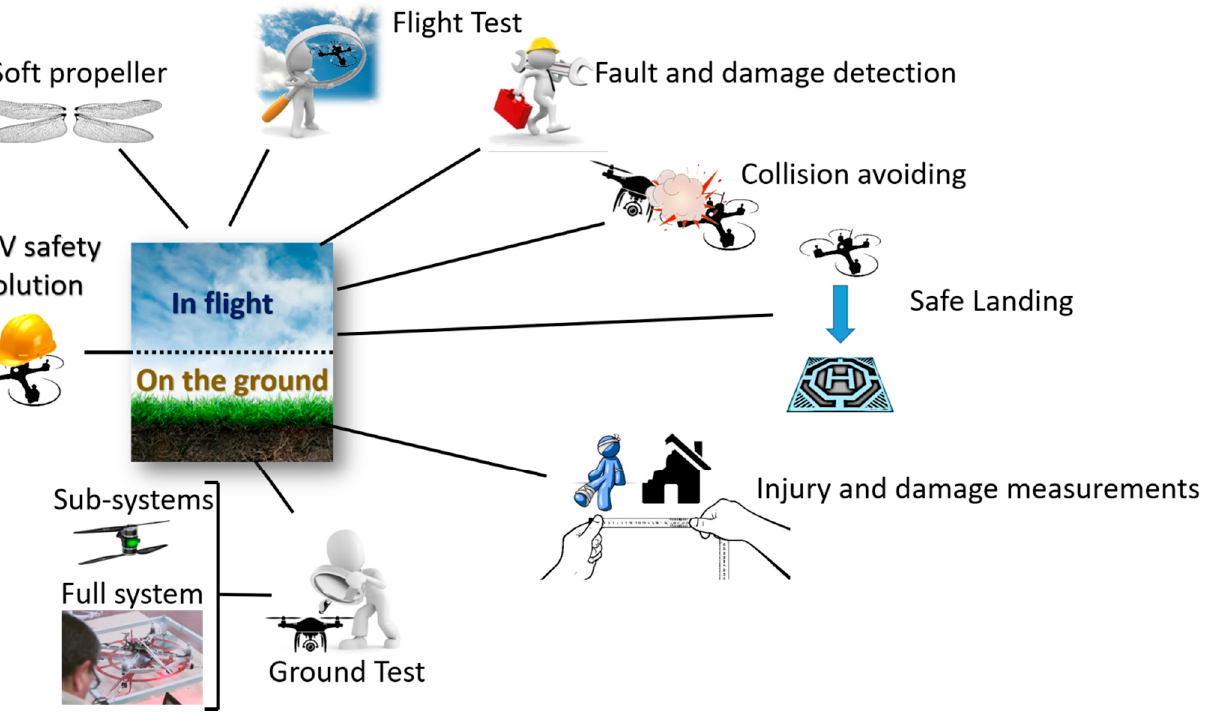
Figure 2. UAV safety solutions proposed classification.